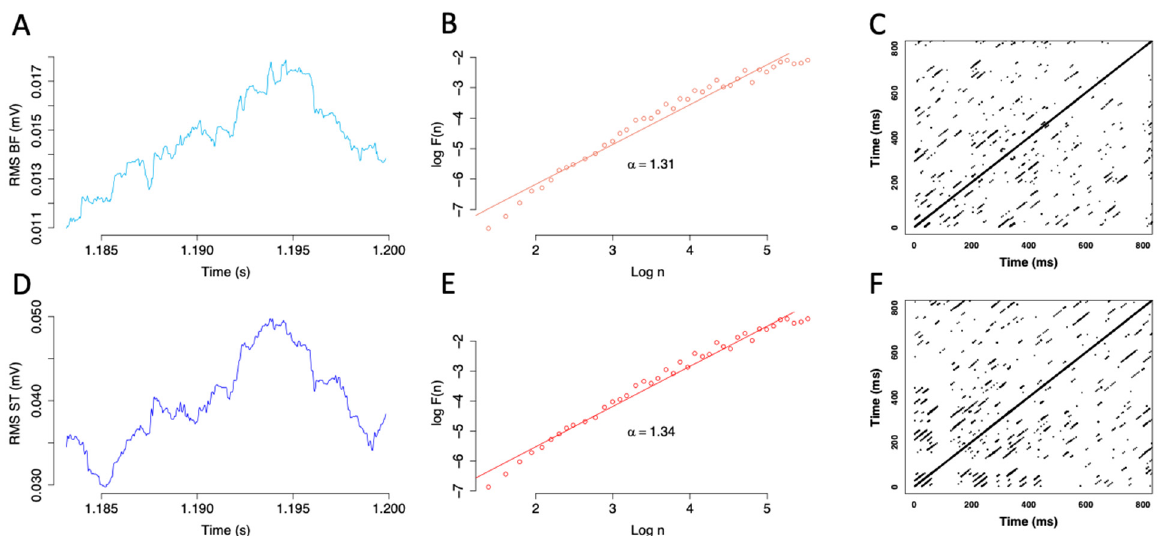
Figure 3. Electromyography (EMG) linear and non-linear analyses for biceps femoris (( B , F ), upper panel) and semitendinosus (ST, lower panel) during a maximal contraction for a representative volunteer. Sliding root mean square (RMS; ( A , D )), detrended fluctuation analysis ( D , F , A ) with the associated a scaling parameter ( B , E ), and recurrence quantification analysis (RQA; ( C , F )).